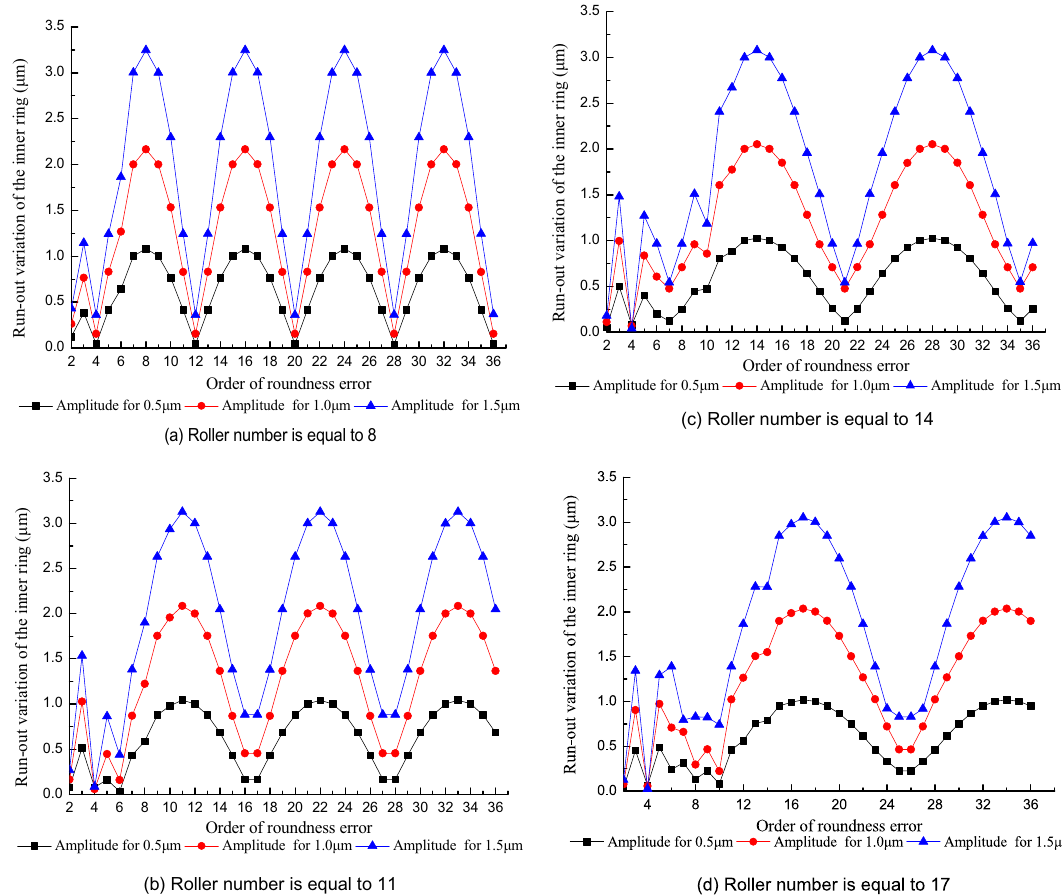
Figure 11. Effect of the order of roundness error in the outer raceway on the run-out variation of the inner